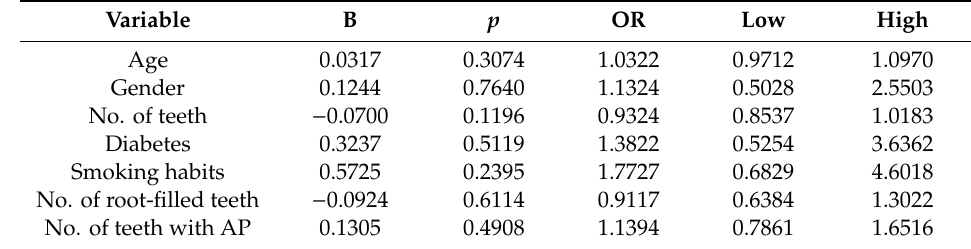
Multivariate logistic regression analysis was also used to assess the relationship of AP with MetS (Table 5). The analysis included as independent variables age, gender, number of teeth, diabetes, smoking habits, number of RFT, and number of teeth with AP, with MetS (0 = absent, 1 = present) the dependent variable. Neither the number of RFT (OR = 0.9; 95% C.I. = 0.6–1.3; p = 0.61) nor the number of teeth with apical periodontitis (OR = 1.1; 95% C.I. = 0.8–1.7; p = 0.49), were associated with MetS. Table 5. Multivariate logistic regression analysis of the influence of the independent variables age, gender (0 = women, 1 = male), number of teeth, diabetes (0 = absent, 1 = present), smoking habits (0 = non-smoker, 1 = smoker), number of root-filled teeth, and number of teeth with apical periodontitis on the dependent variable “metabolic syndrome” (0 = absent, 1 = present).